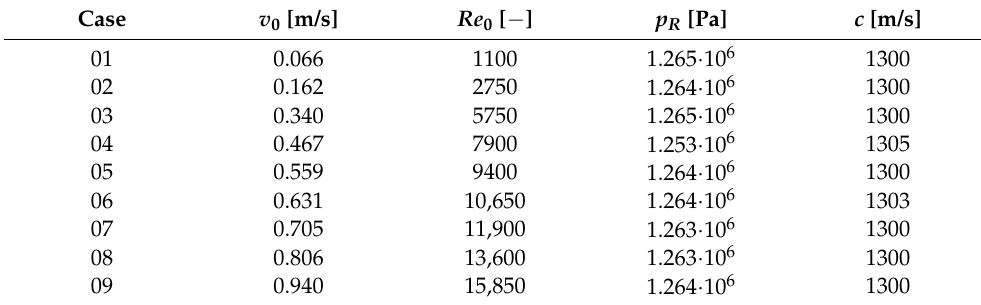
Table 2. Analysed flow